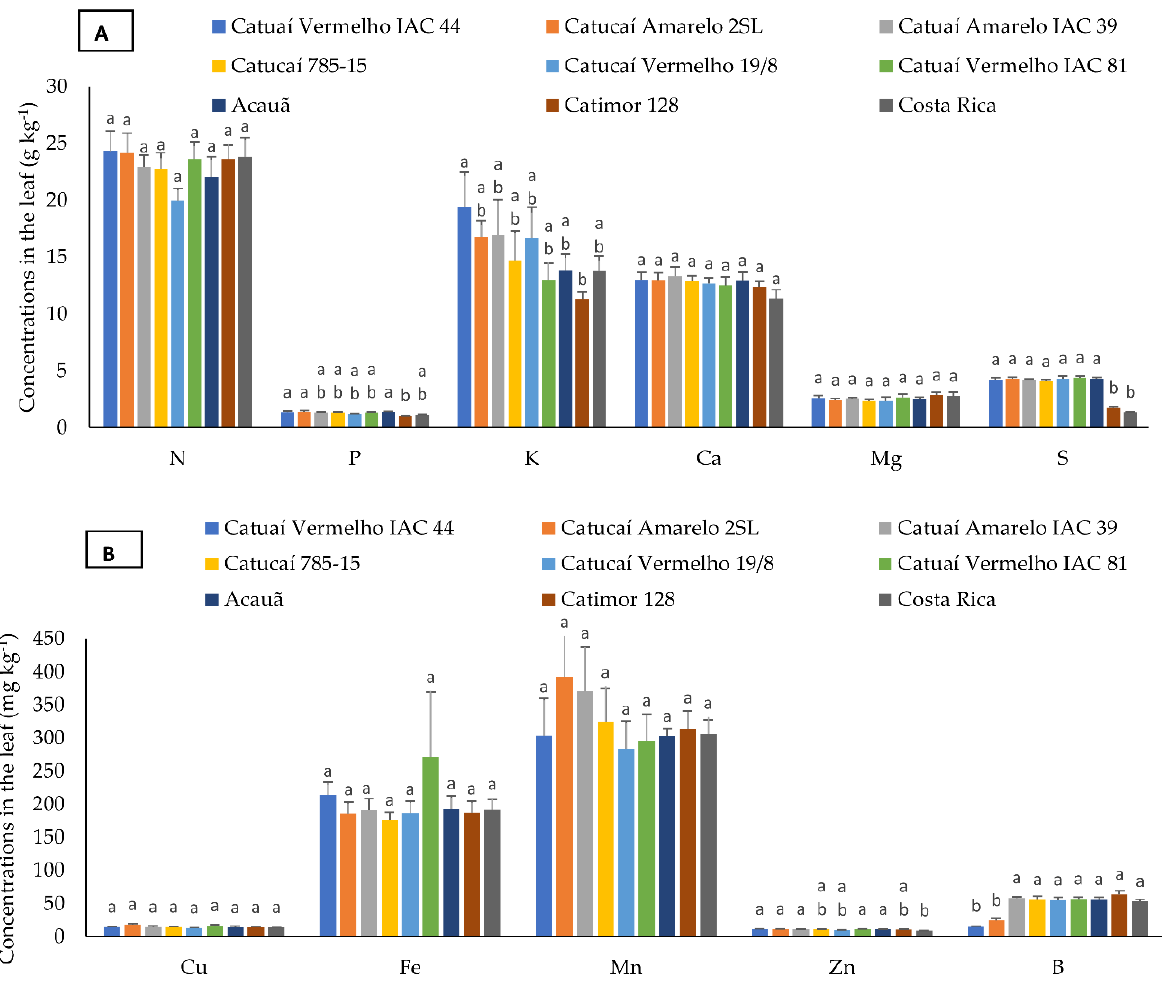
Figure 4. Concentration of macronutrients ( A ) and micronutrients ( B ) in the leaves of nine Coffea arabica cultivars grown in Gorongosa National Park, Mozambique. For each parameter, the mean values ± SE (n = 4) followed by different letters indicate significant differences between cultivars (a, b).